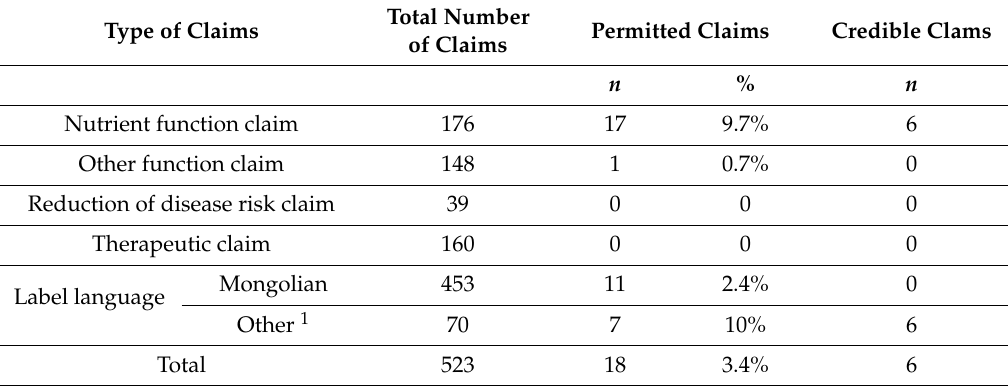
Table 5. Comparison of health claims with the authorised claims in the